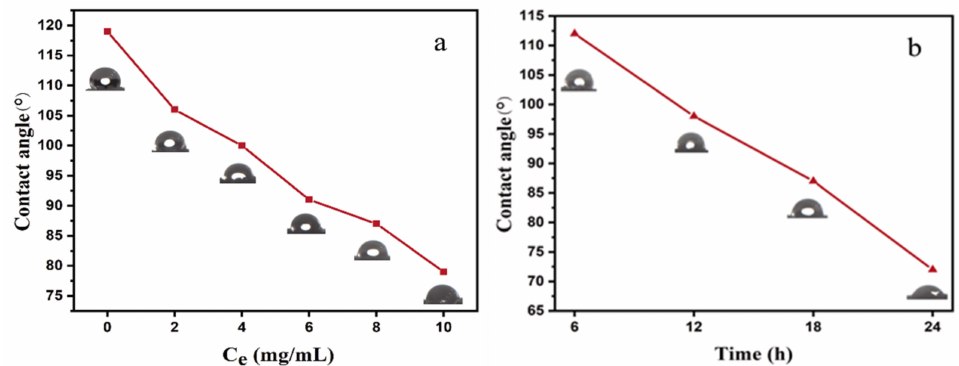
Figure 4. ( a ) CAs of NRS and PNRS coated with different concentrations of dopamine solution, ( b ) CAs of PNRS modified by different time (C e = 8